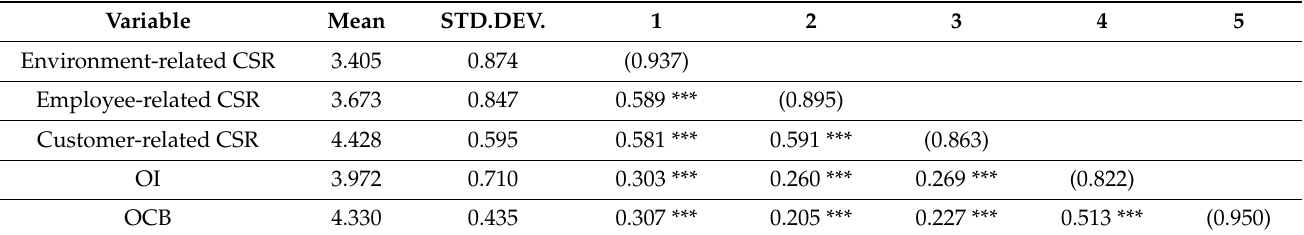
Table 3. Means, standard deviations and correlations of construct-related